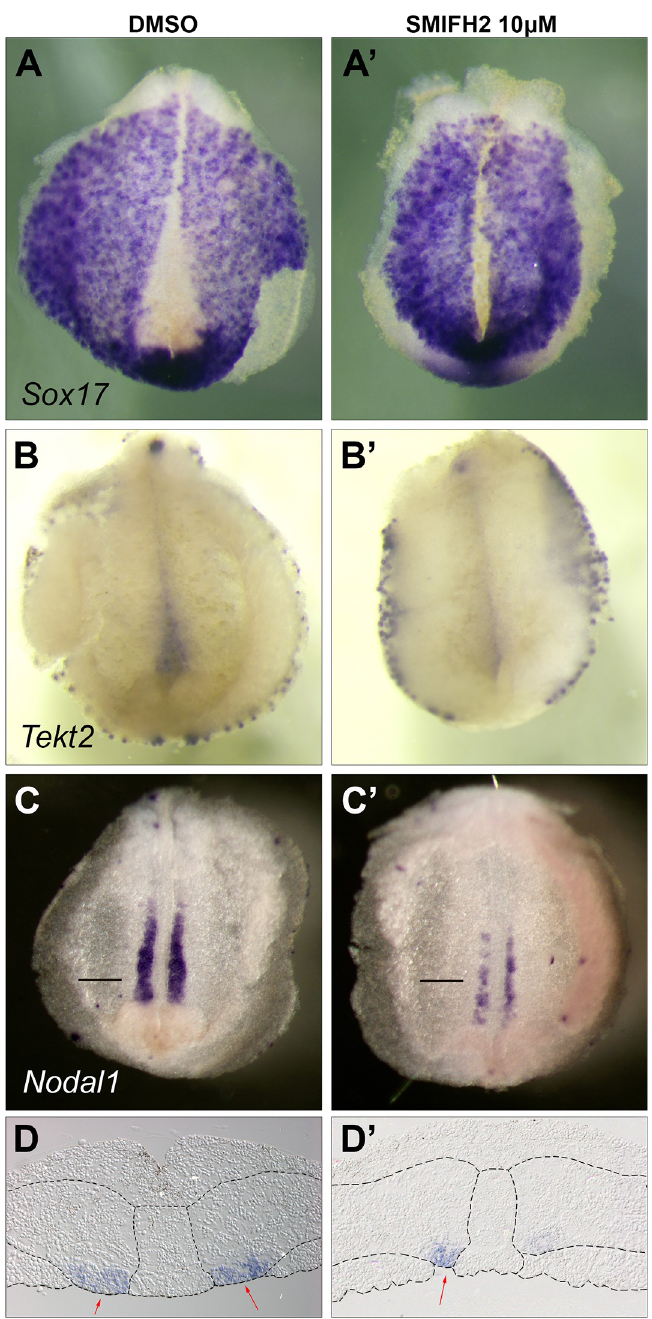
Fig 3. Formin inhibition at gastrula and neurula stages results in abnormal molecular patterning of GRP. (A-B’) Representative images of molecular patterning in the GRP. Dorsal explants of stage 18 neurula embryos after control treatment (A,B) and SMIFH2 administration (A’,B’) at stages 10–18. In situ hybridisation was performed with probes specific for sox17 (A,A’) and tekt2 (B,B’). (C and C’) Representative images of nodal1 expression pattern in the GRP. Dorsal explants of stage 18 neurula embryos after control or SMIFH2 treatment at stages 10–18. (D and D’) Histological sections through GRP demonstrate the position of nodal1- positive cells in the prospective somitic mesoderm. Arrows indicate areas of superficial nodal1 -positive cells.